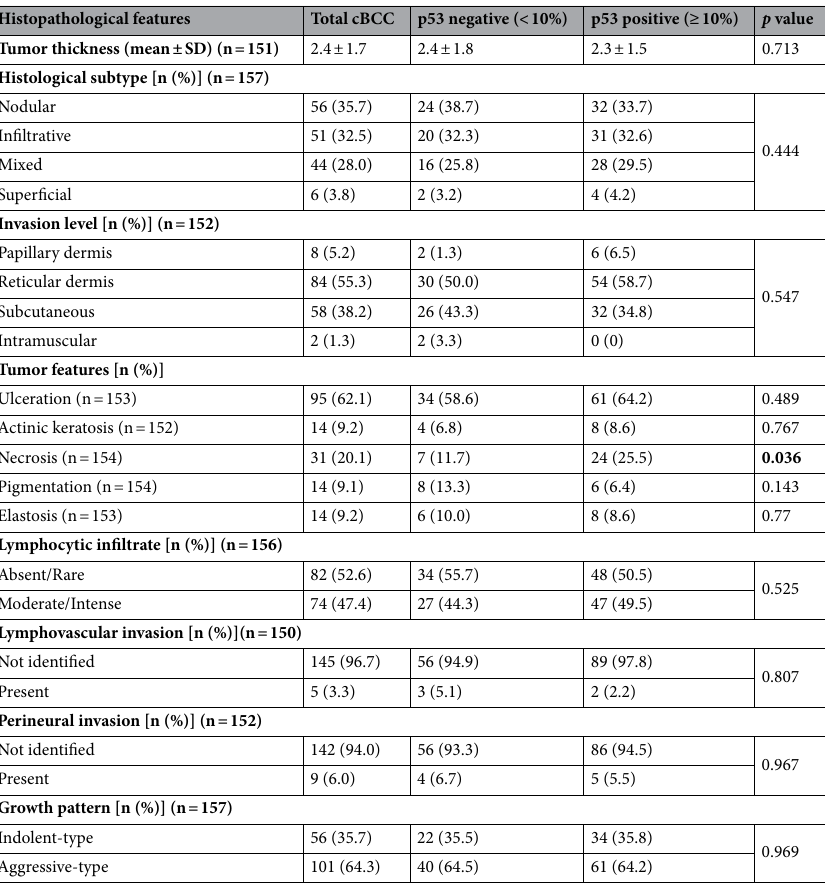
Table 2. cBCCs histopathological features and p53 expression. Bold - significant difference ( p -value < 0.05).